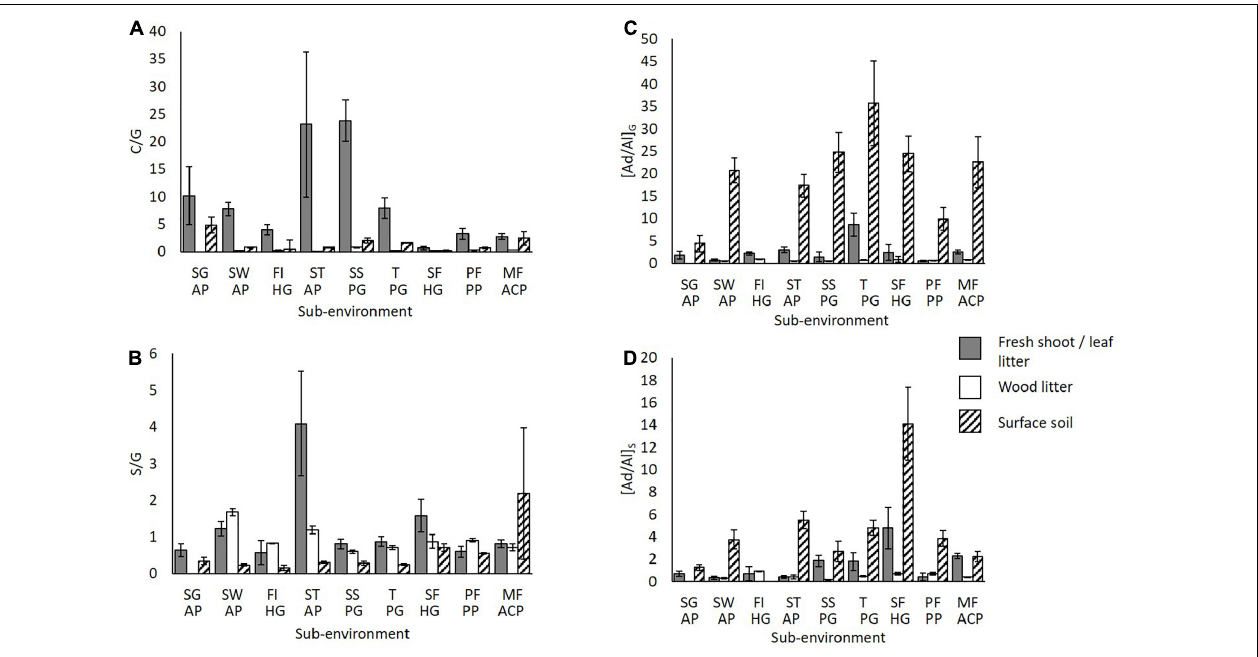
FIGURE 6 | Lignin parameters (A) C/G and (B) S/G of surface soils and vegetation inputs across the transect and oxidation extents of (C) [Ad/Al] G and (D) [Ad/Al] S of surface soils and vegetation inputs in sub-environments across the transect. S.E. bars of 3 replicates are shown. SG AP, Savannah Grassland Albic Plinthosol; SW AP, Savannah Woodland Albic Plinthosol; FI HG, Forest Island Humic Gleysol; ST AP, Savannah Tree Albic Plinthosol; SS PG, Savannah Swamp Plinthic Gleysol; T PG, Transition zone Plinthic Gleysol; SF HG, Swamp Forest Humic Gleysol; PF PP, Pisoplinthic Forest Pisoplinthic Plinthosol; MF ACP, Mixed Forest Acric